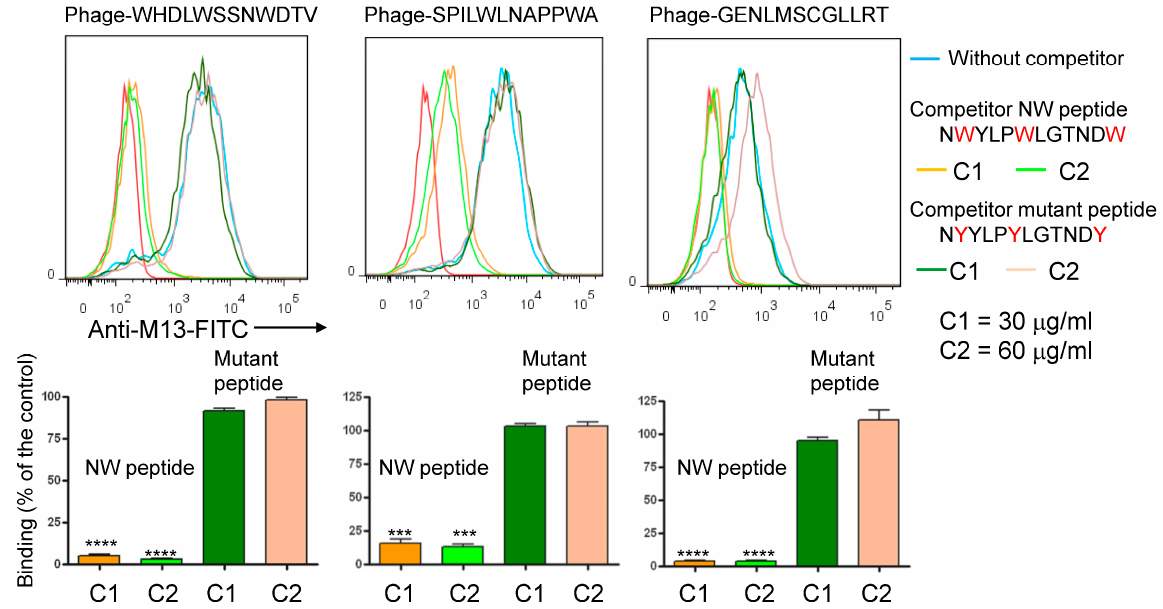
Figure 3. Inhibition of the phage-displayed peptide binding by NW peptide. M2 macrophages were pre-incubated with either the NW peptide or its mutant form and then stained with the indicated phage-displayed peptides (10 7 TU/mL) followed by flow cytometry analysis. The binding of the phages was detected using FITC-conjugated anti-M13 monoclonal antibody. Lower panels represent the percentage of inhibition. Florescence of cells without competitor is taken as a control (100%). *** p < 0.001, **** p < 0.0001.